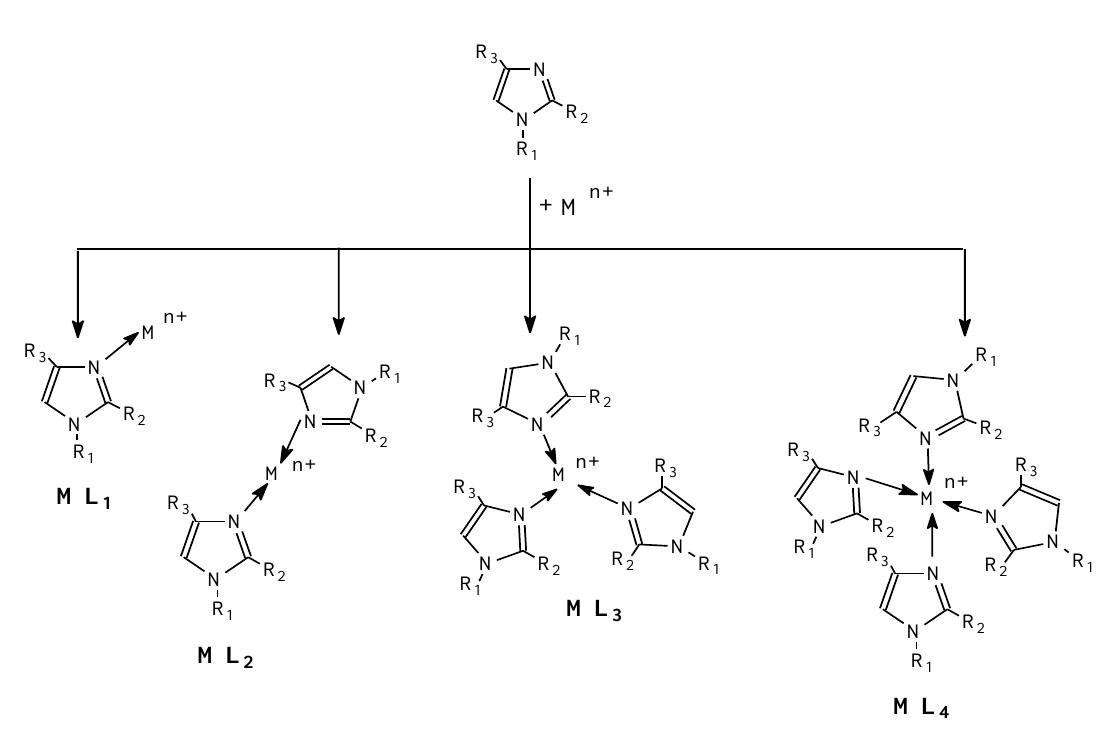
Figure 7. Complex formation.